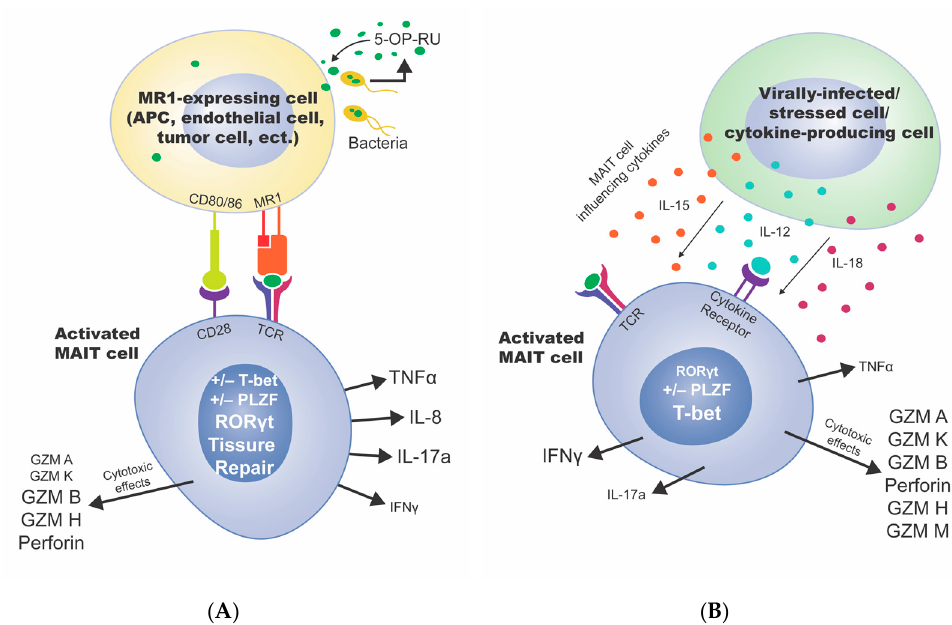
Figure 2. Mechanisms of MAIT cell activation. ( A ) TCR-Dependent activation via MR1 on an MR1-expressing cell (includes antigen presenting cells, endothelial cells, tumor cells, etc.). In this context, an antigen (bacterially produced 5-OP-RU) is taken up into the cell and presented in MR1. The TCR from the MAIT cell engages MR1 and other co-stimulatory molecules like CD28/CD80. Transcription factors ROR γ t, PLZF, T-bet, and tissue repair genes are expressed. Cytokines such as TNF- α , IL-8, IL-17a, and IFN- γ , are secreted, as well as cytotoxic effector granules like GZMA, GZMK, GZMB, GZMH, and perforin. The size of the text reflects the relative secretion of each molecule, whereas bigger text indicates more secretion and smaller text is less secretion, specific to the type of activation pictured. ( B ) TCR-Independent activation via cytokine release from other cells such as virally infected cells, stressed cells, or other cytokine-producing cells. MAIT cells are not only activated by MR1-TCR binding, but also by cytokines IL-15, IL-12, and IL-18. When the cytokine receptor is bound, cytokines TNF- α , IFN- γ , and IL-17a are secreted, as well as cytotoxic effector granules like GZMA, GZMK, GZMB, perforin, GZMH, and GZMM. Transcription factors ROR γ t, PLZF, and T-bet are expressed. The size of the text reflects the relative secretion of each molecule, whereas bigger text indicates more secretion and smaller text is less secretion, specific to the type of activation pictured.